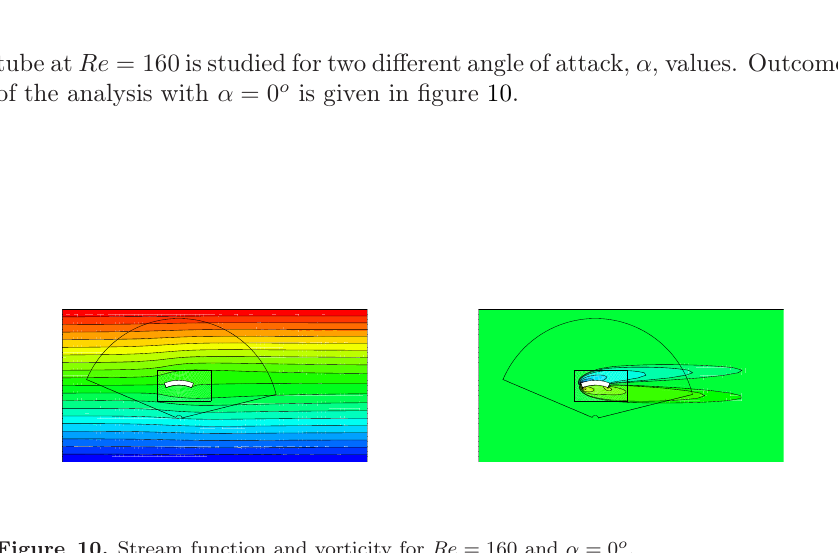
Figure 10. Stream function and vorticity for Re = 160 and α = 0 o